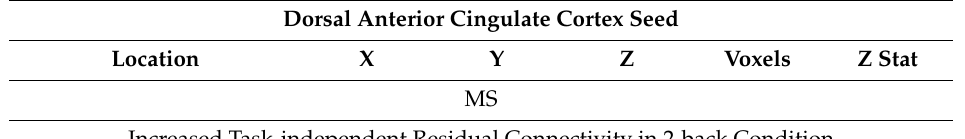
Table 5. Task-independent (residual) fatigue-related functional connectivity with the dorsal anterior cingulate cortex as seed.